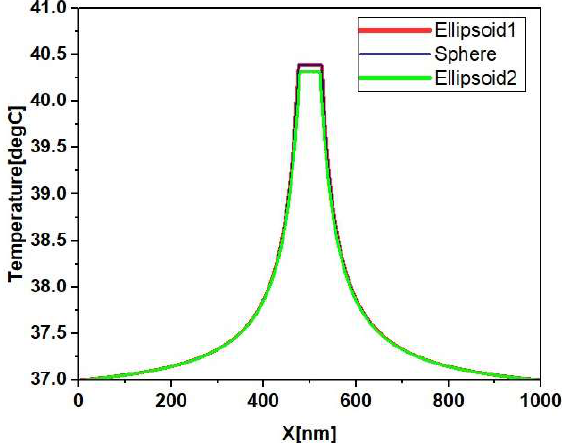
Figure 9 . Radial temperature distributions of different coated shapes. Figure 9. Radial temperature distributions of different coated shapes.